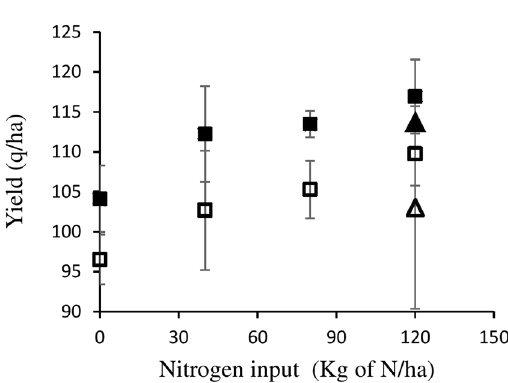
Figure 1. Impact of nitrogen fertilization on maize grain yield. A . lipoferum CRT1-coated (full symbols) and mock-coated (open symbols) maize seeds were sown in 2014 in field A. Nitrogen was added as ammonium nitrate (33.5% nitrogen N). Nitrogen fertilization was either added once at the 6-leaf stage for all doses (squares) or in two equal amounts at sowing and the 6-leaf stage (triangles) at a total of 120 Kg of N/ha (i.e. 358.2 Kg ammonium nitrate/ha). Means + / − SE are shown (n = 5 blocs in randomized split-plot